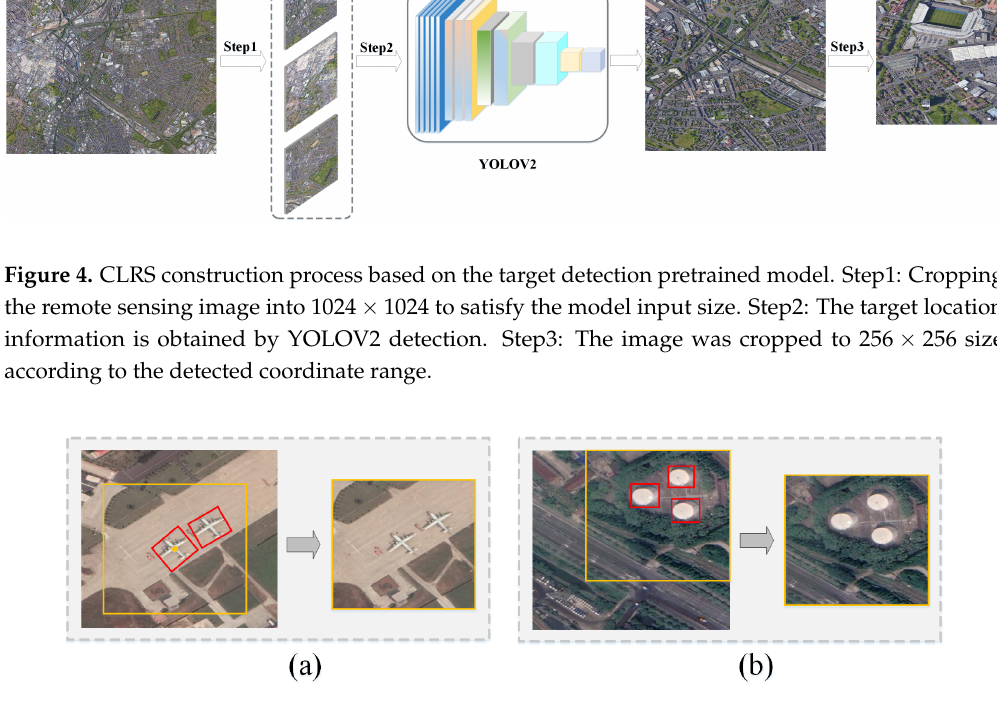
Figure 5. Cropping principles. ( a ) Detected object is at the center of the remote sensing image: crop the image according to the center of the object. ( b ) Detected object is on the edge of the remote sensing image: crop the image according to the boundary of remote sensing